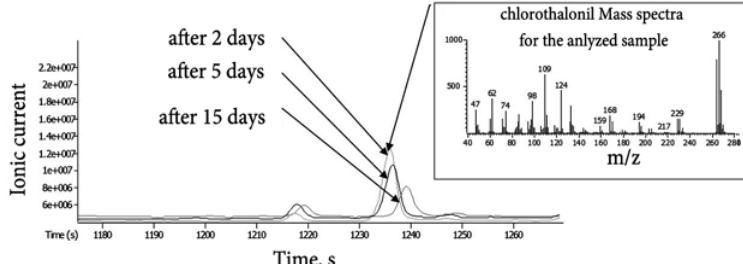
Fig. 2. Chromatogram of chlorothalonil degradation in apples after 2, 5 and 15 days for the phenological stage 30–40 mm fruit size (BBCH